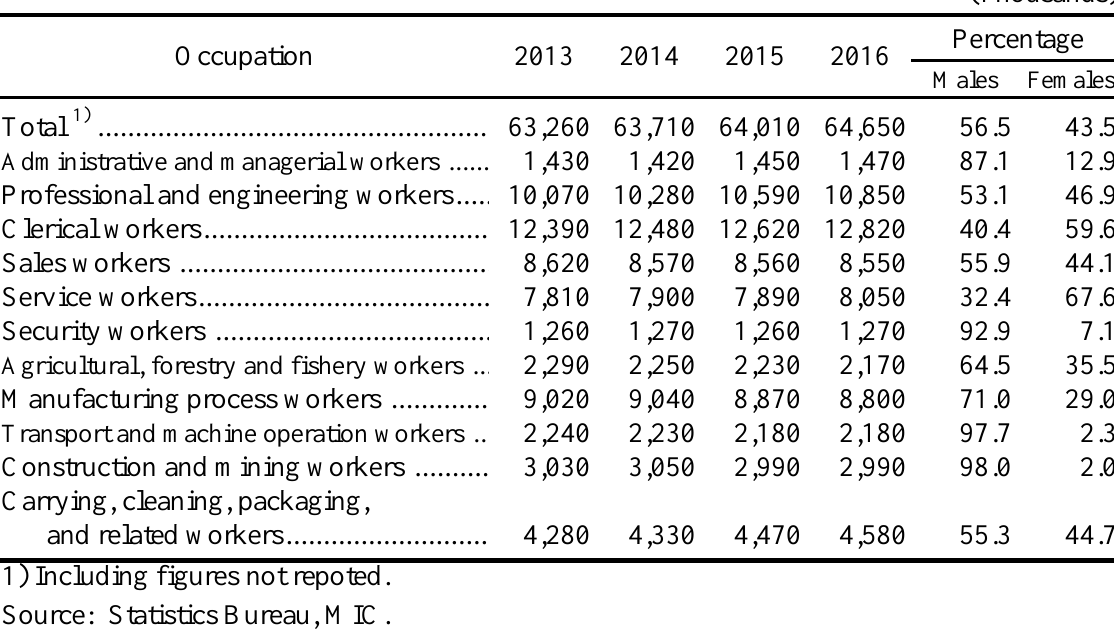
Table 12.3 Employment by